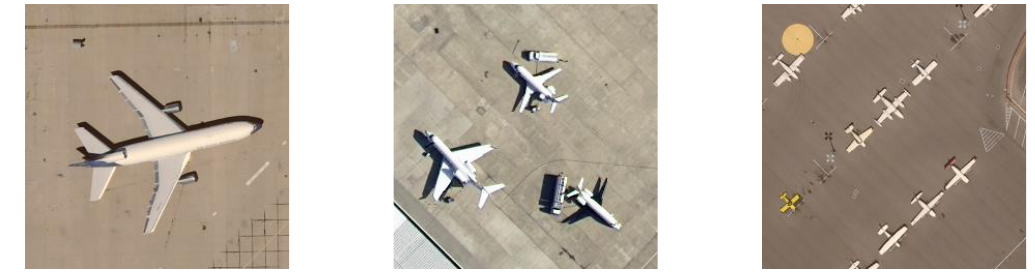
Figure 1. Examples of object scale variation in remote sensing images.